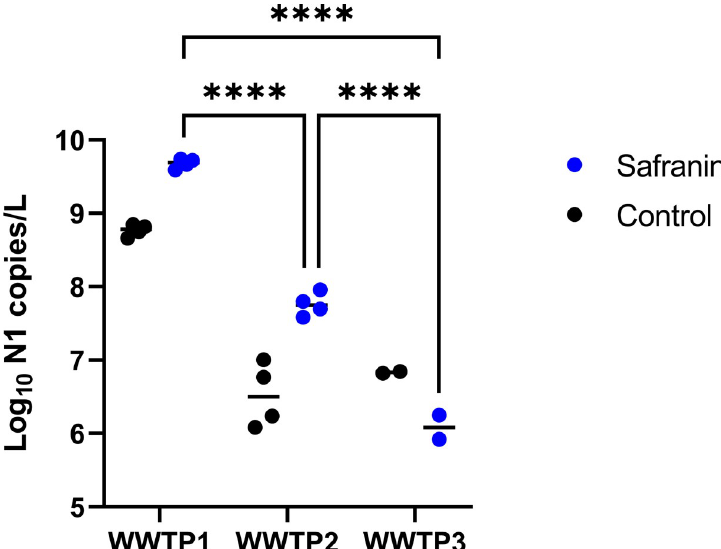
Fig 5. Effect of safranin staining: Copy number yield for the N1 target for 24-hr composite wastewater samples obtained from 3 wastewater treatment plants. Samples processed with safranin are labeled by dark blue circles; controls are labeled with light blue circles. Points are technical replicate measurements from a 24-hour composite sample. Horizontal black lines show means. See Fig 2 legend for explanation of pairwise comparisons.